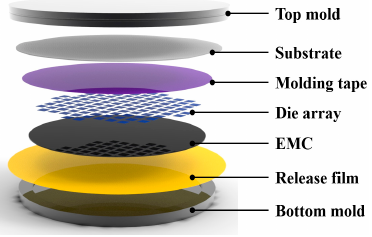
Figure 3. Components of compression molding.